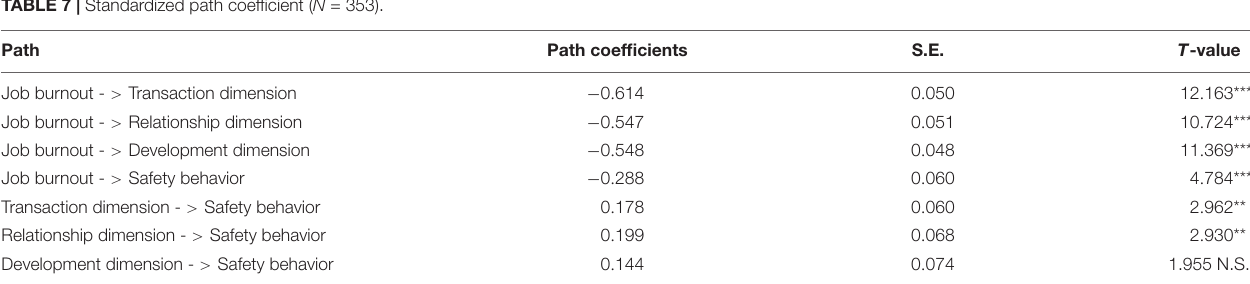
TABLE 7 | Standardized path coefficient ( N =